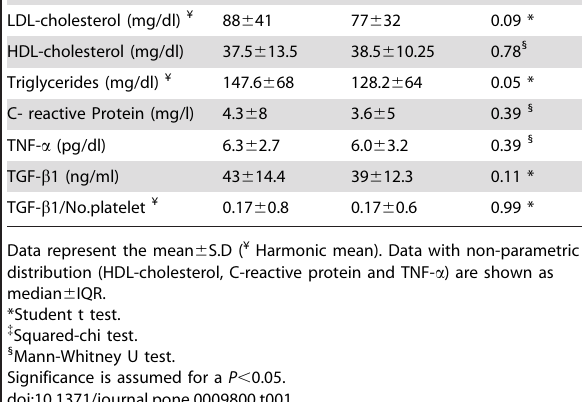
Data represent the mean 6 S.D ( ¥ Harmonic mean). Data with non-parametric distribution (HDL-cholesterol, C-reactive protein and TNF- a ) are shown as median 6 IQR. *Student t